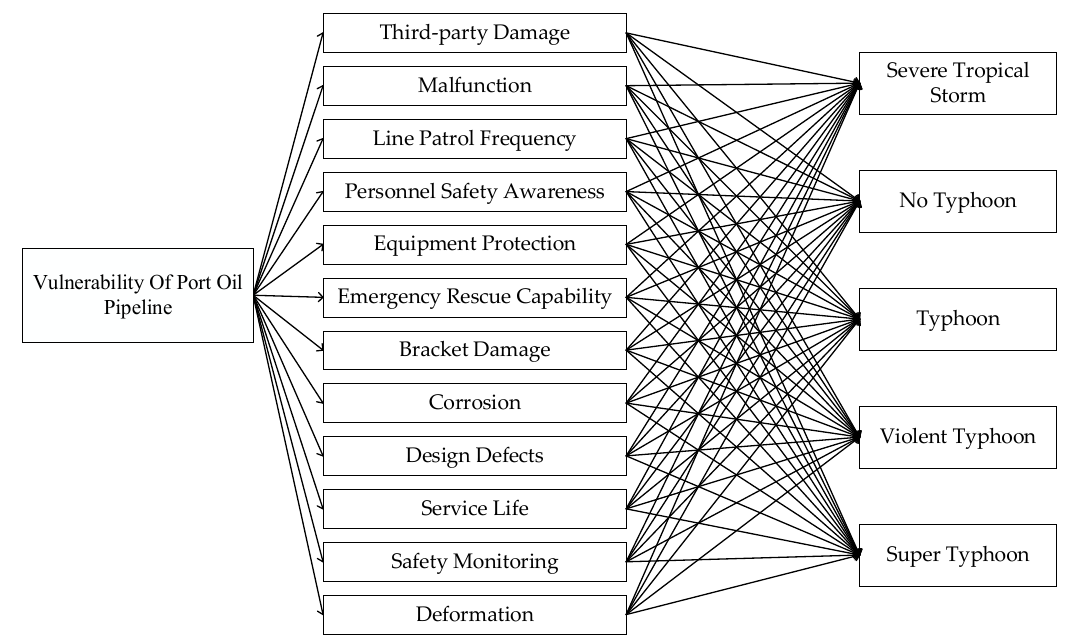
Figure 3. Vulnerability evaluation index system for the pipeline under the influence of different typhoon intensity.